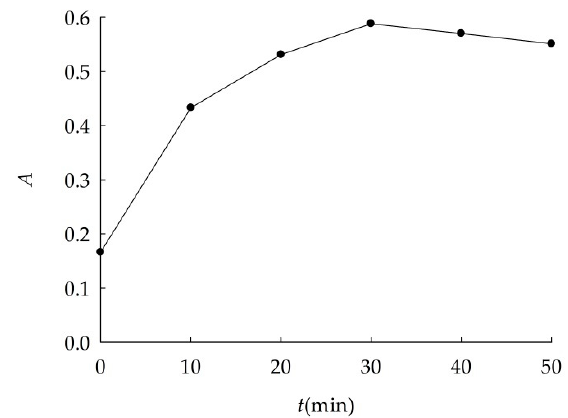
Figure 1. Absorbance ( A ) curve of nano-Al 2 O 3 suspension at different ultrasonic time.